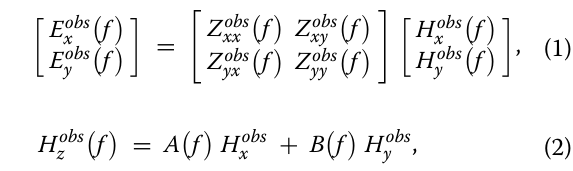
and imaginary part of each impedance tensor element, respectively. The phase tensor indicates the degree of subsurface resistivity heterogeneity (dimensionality). The phase tensor is diagonalized to determine its